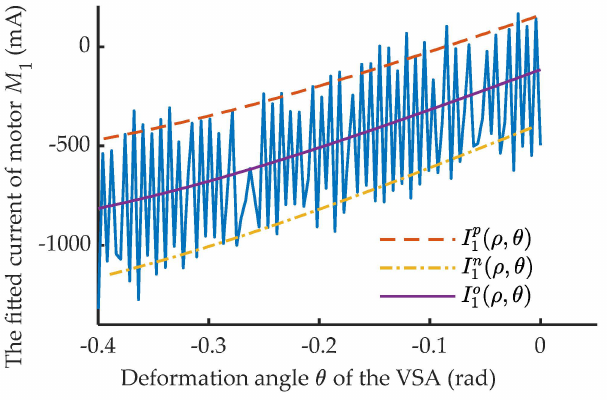
Figure 15. Current estimation for cam C 1 ( AB > OA , ρ = 0.048 m).